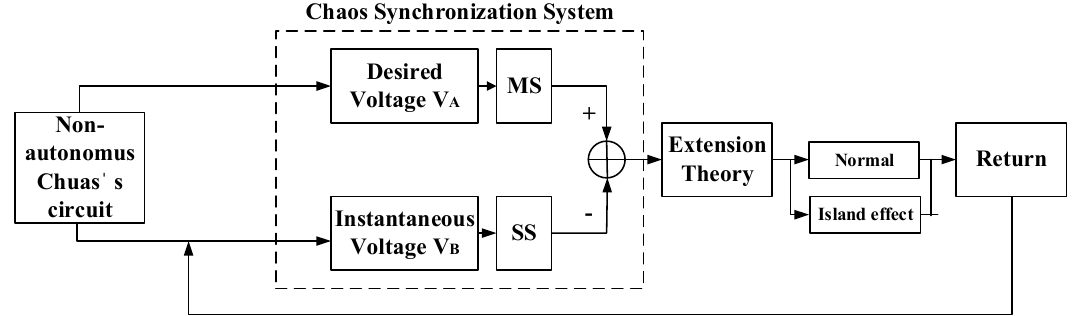
Figure 5. Flow chart of the islanding diagnosis system.